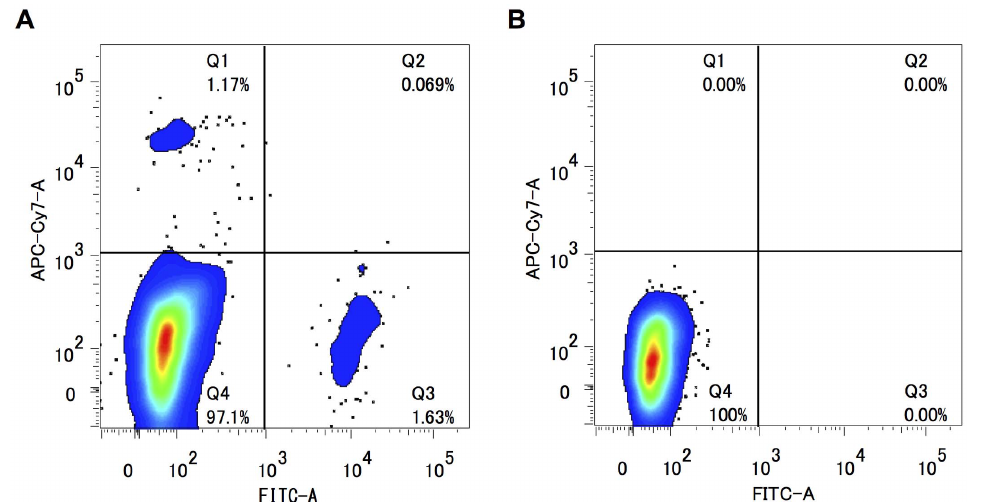
Figure 1. CD31 + cells successfully divided from whole tissue by FACS. A) Population of cells reacted with FITC-conjugated anti-CD31 antibody (CD31) and APC/Cy7-conjugated anti-CD45 antibody (CD45). CD31 2 /CD45 2 : consisting mainly of SMCs, CD31 + /CD45 2 : consisting entirely of ECs B) Population of cells reacted with fluorescence conjugated anti-control IgG antibodies in order to confirm the nonspecific binding of antibodies.